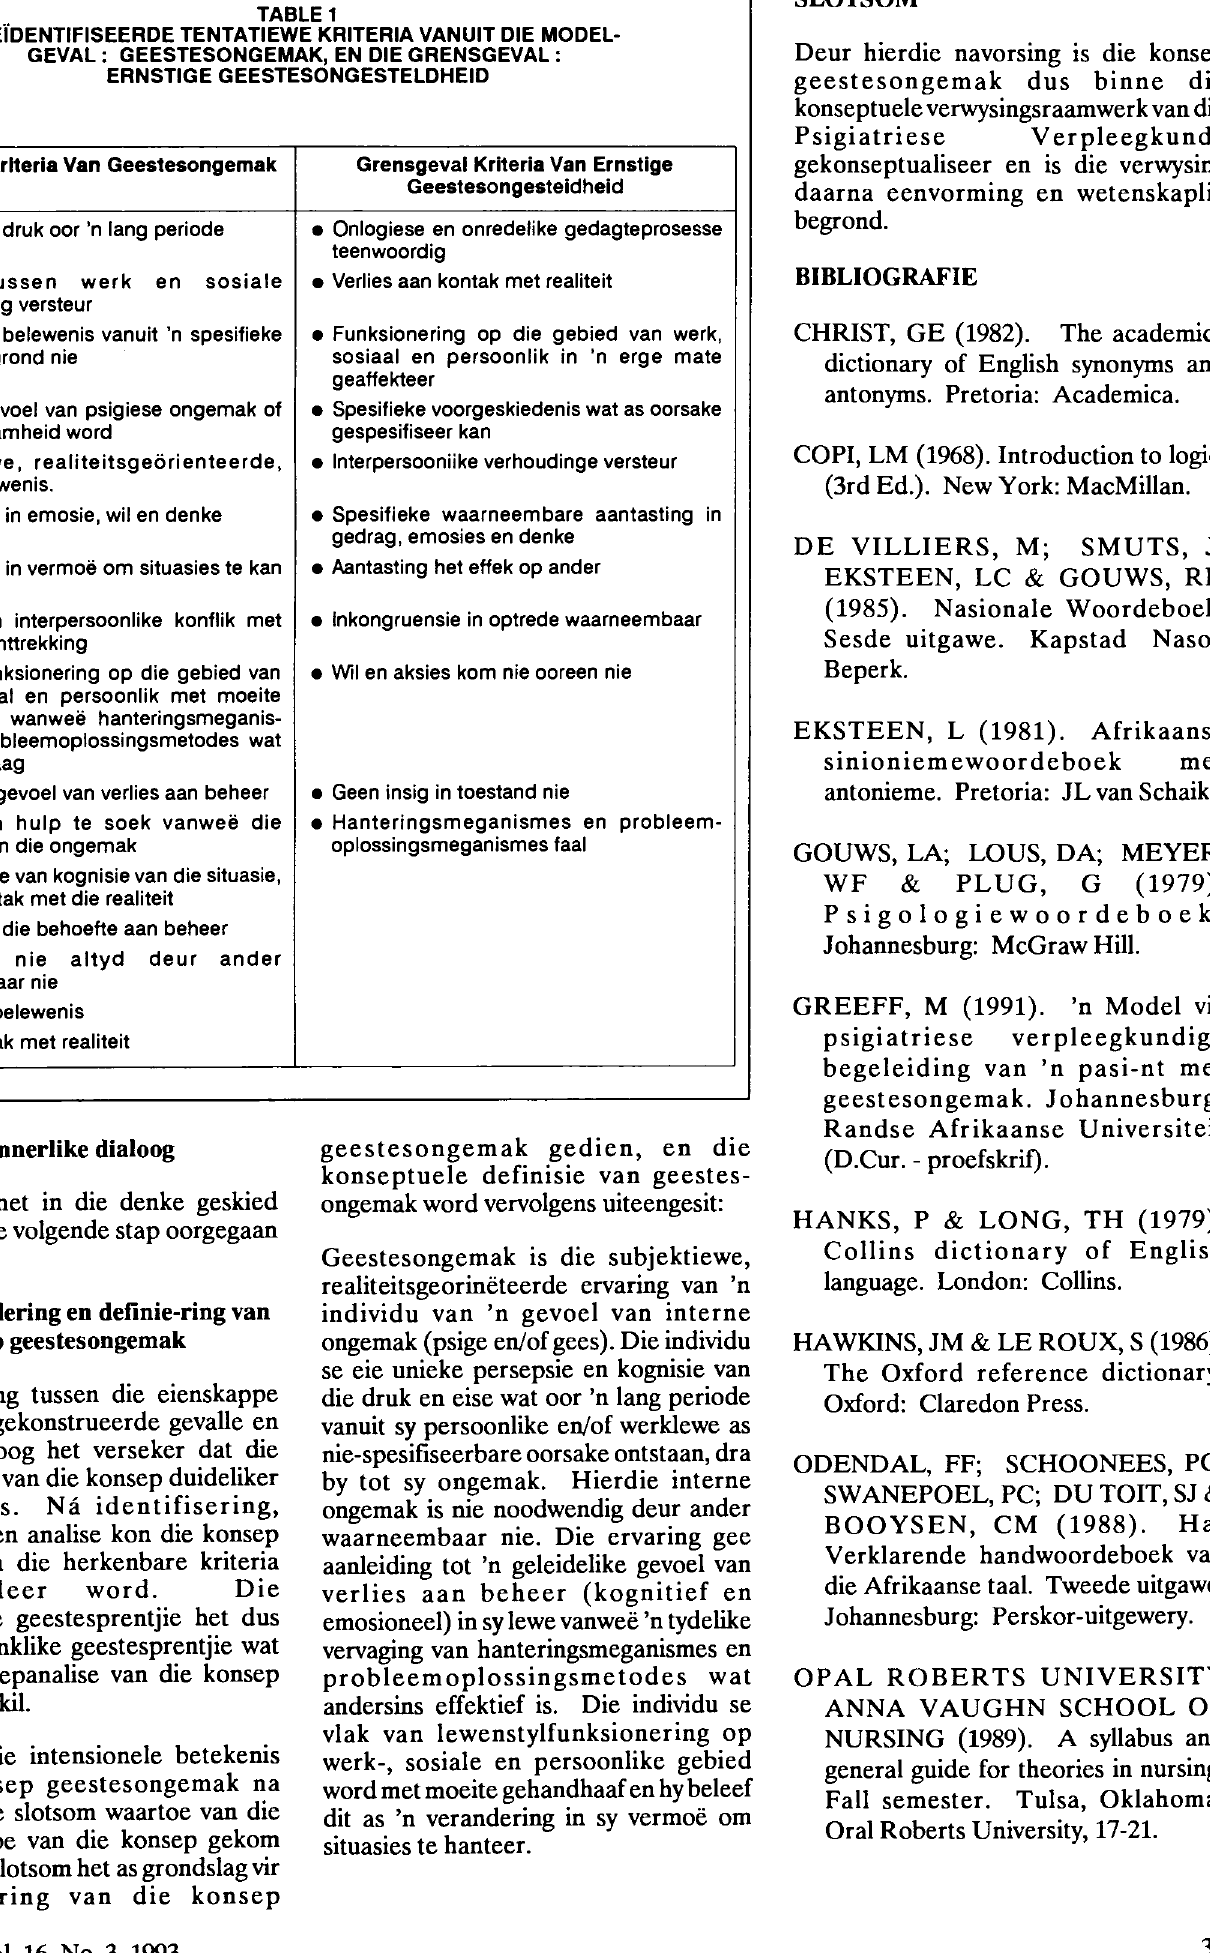
Modelgeval Krlterla Van